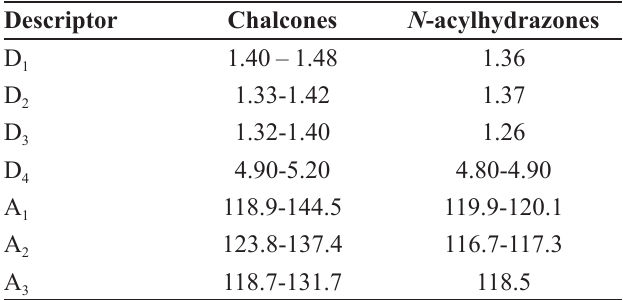
) versus structural descriptors. 50 TABLE II - Topological and structural parameters calculated for the investigated compounds